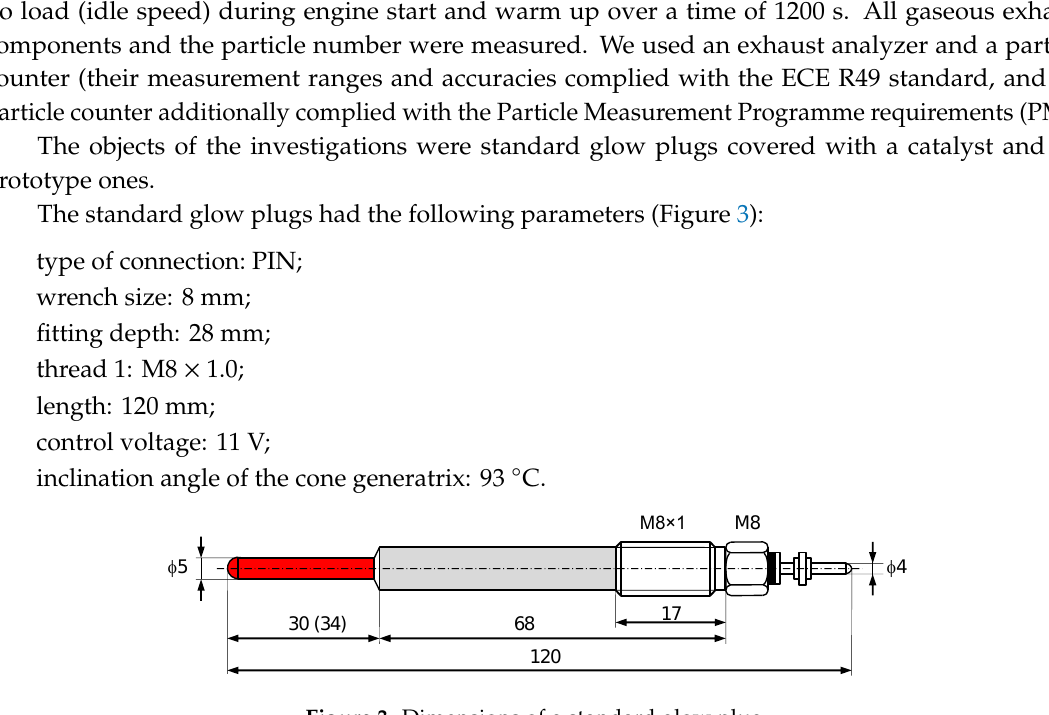
Figure 3. Dimensions of a standard glow plug.